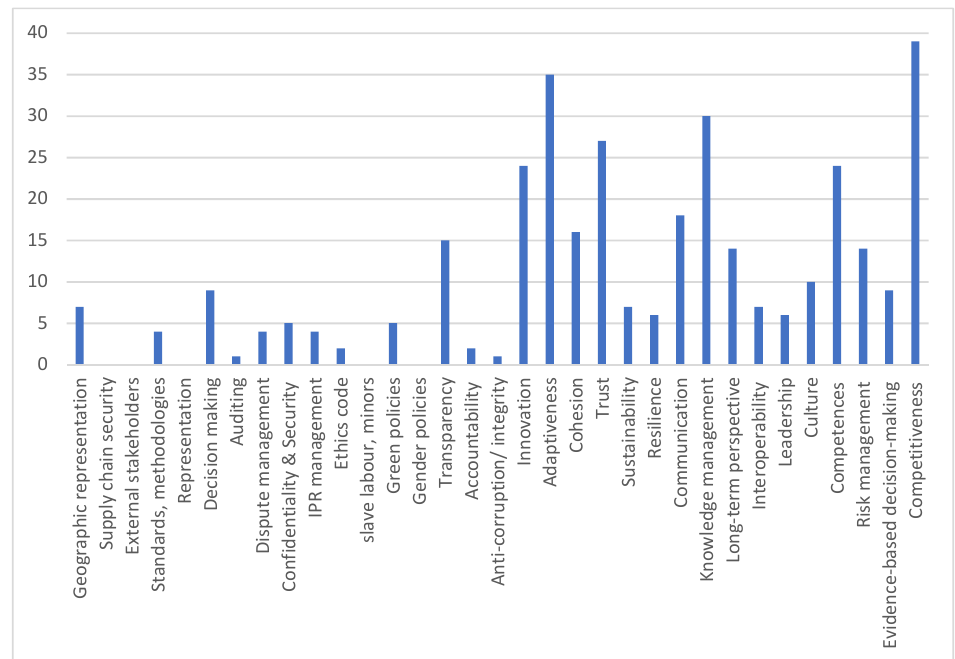
Figure 1. Number of referencing academic sources per governance issue.